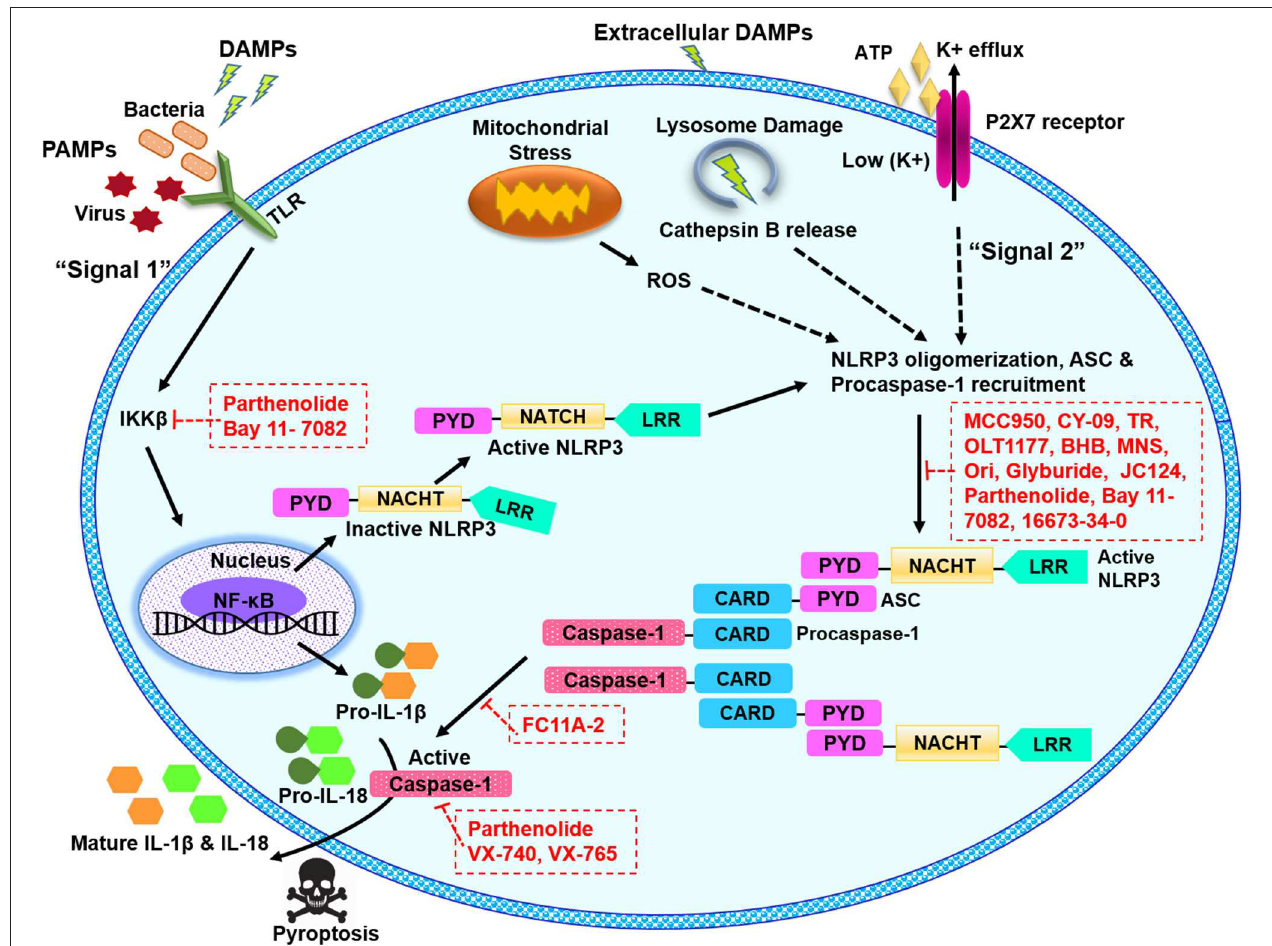
FIGURE 1 | Schematic illustration of NLRP3 inflammasome pathway and potential blockade sites of various pharmacological inhibitors. The signal 1 or the priming signal is mediated by pathogenic PAMPs from bacteria or virus, or sterile DAMPs resulting in NF- κ B-dependent upregulation of NLRP3 and pro-IL-1 β expression. The signal 2 or activation signal mediated by numerous PAMP or DAMP stimulation, promotes the NLRP3 oligomerization, and recruitment of ASC and pro-caspase-1, leading to the activation of NLRP3 inflammasome complex. NLRP3 can be activated in response to extracellular ATP and K + efflux through the ATP-gated P2X7 channel, in response to cathepsin B release from damaged lysosomes or in response to reactive oxygen species (ROS) released from damaged mitochondria. NLRP3 inflammasome activation results in active caspase-1, which cleaves the proforms of IL-1 β and IL-18 into their mature forms. ASC, apoptosis-associated speck-like protein containing a C-terminal caspase recruitment domain; ATP, adenosine triphosphate; BHB, β -Hydroxybutyrate; CARD, caspase recruitment domain; DAMPS, danger or damage associated molecular patterns; IL, interleukin; LRR, leucine-rich repeat; MNS, methylenedioxy- β -nitrostyrene; NACHT, central nucleotide-binding and oligomerization; NF- κ B, nuclear factor kappa B; Ori, oridonin; P2X7, P2X purinergic receptor 7; PAMPS, pathogen associated molecular patterns; PYD, pyrin domain; ROS, reactive oxygen species; TLR, toll-like receptor; TR,